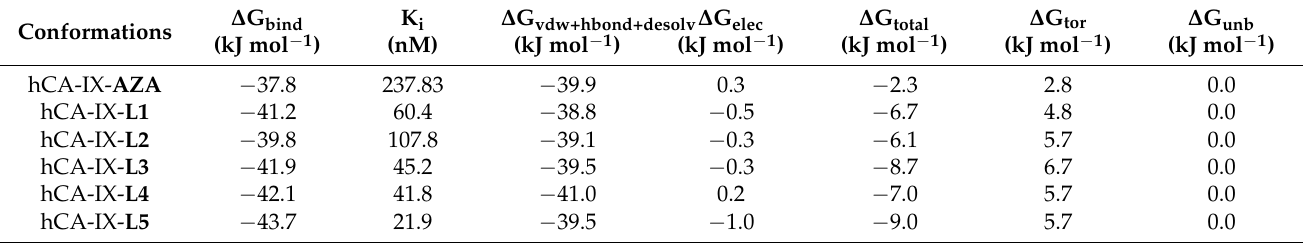
Table 6. The important thermodynamic parameters for the best docking conformations of the investigated molecules with the hCA-IX receptor (PDB ID: